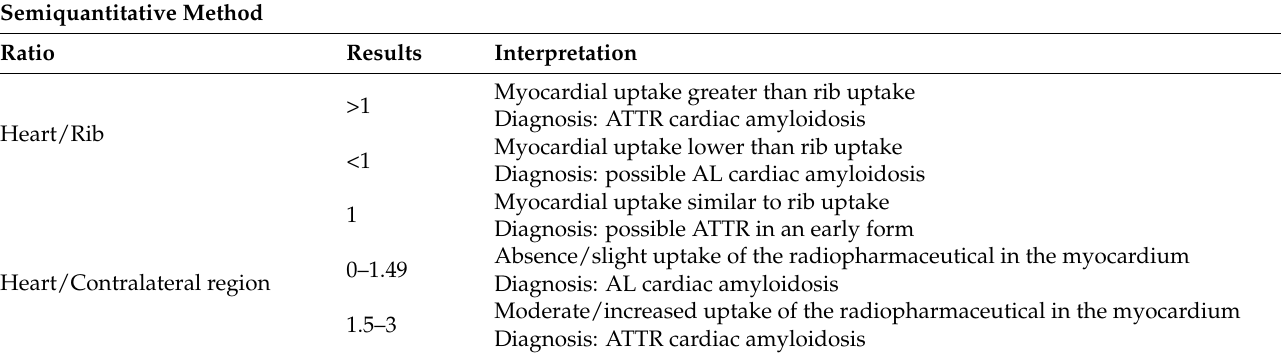
Table 1. Semiquantitative method classification based on ROI